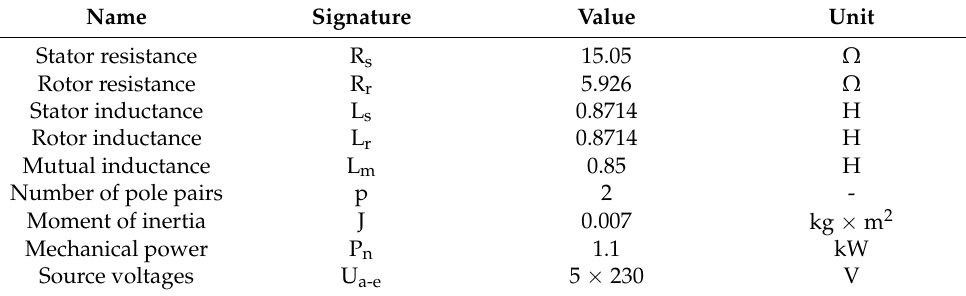
Table 1. Five-phase induction motor